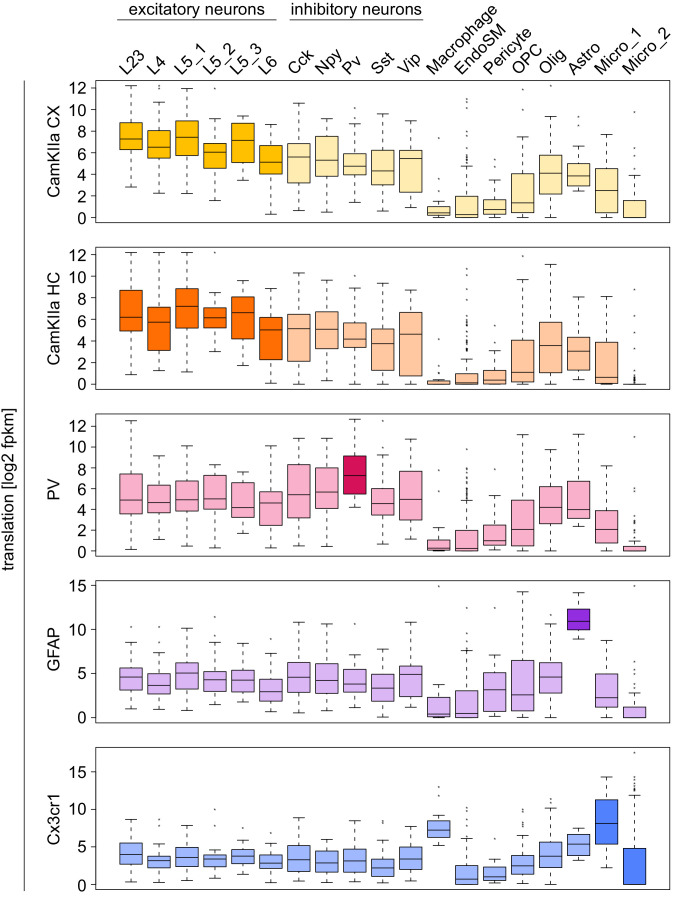
Marker genes are highly translated in the corresponding cell type.Boxplots displaying the translation of marker genes for excitatory neurons (L23/4/5_1/5_2/5_3/6), inhibitory neurons (Cck/Npy/Pv/Sst/Vip) and other cell types (Ref) in the indicated cell type. Boxes containing genes expected to be highly translated are shaded in a darker tone.